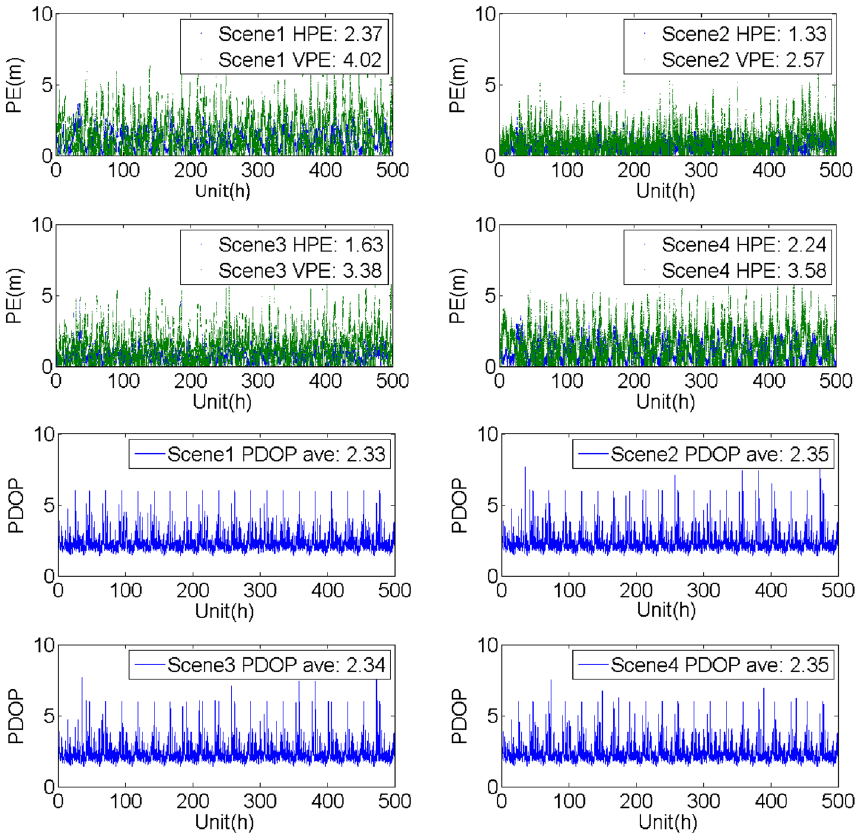
Figure 11. Evaluation of the PE and PDOP under different scenes in Sanya known point from Dec 11 to 31,